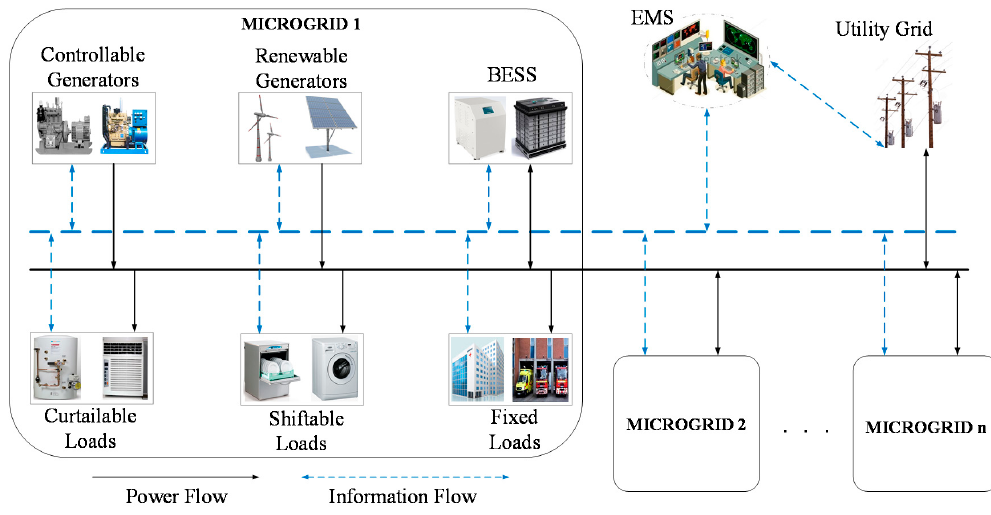
Figure 3. A typical networked microgrid.